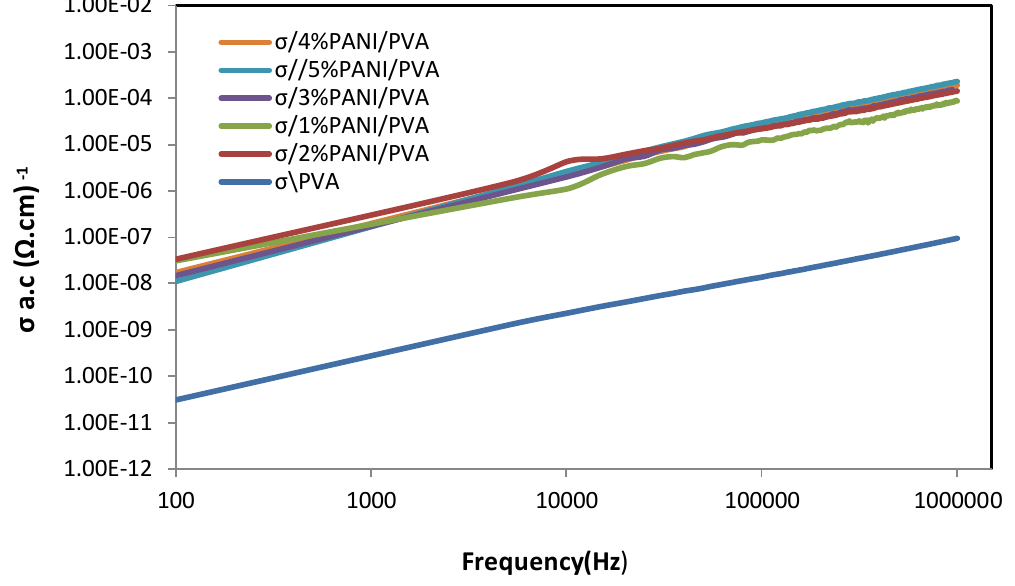
Figure 3: A.C conductivity as a function of frequency for PVA before and after PANI addition